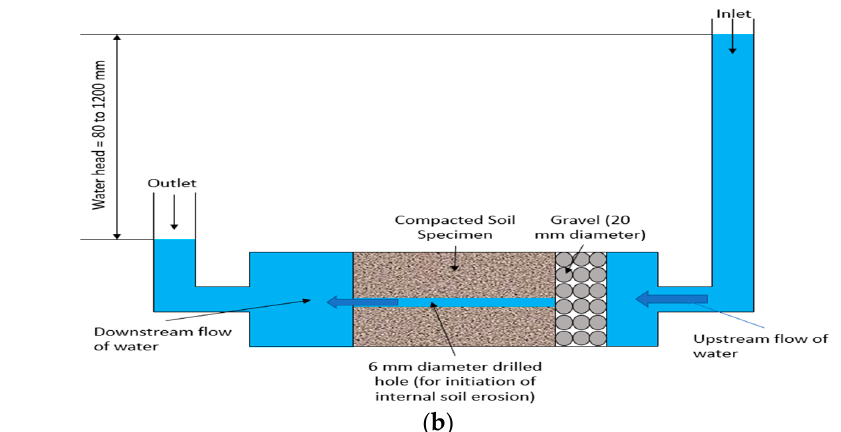
Table 2. Quicklime properties used in this study.